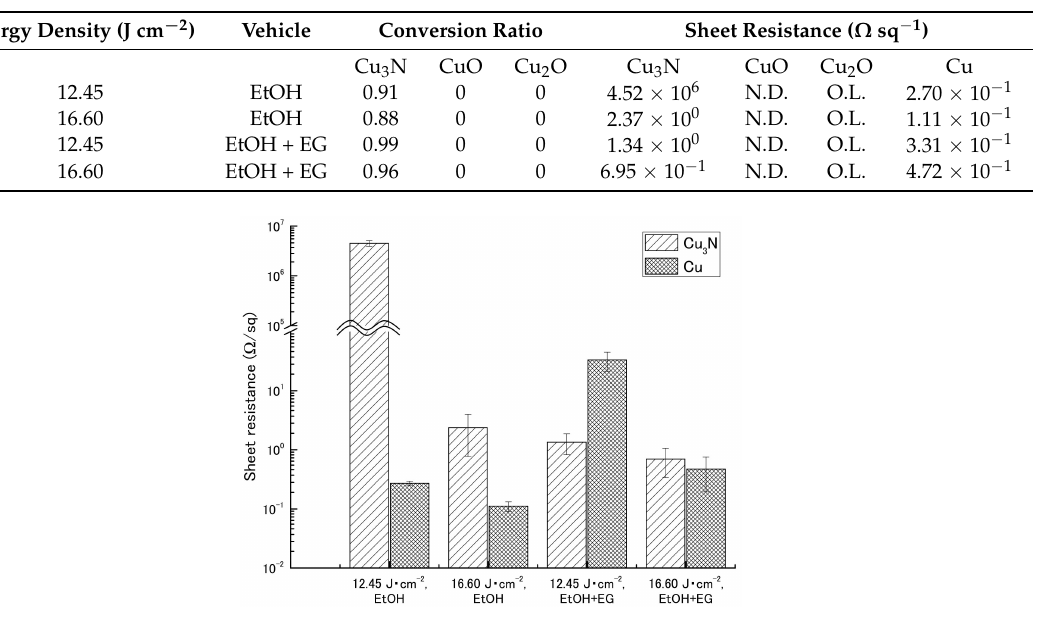
Figure 3. Sheet resistance of films containing copper nitride (Cu 3 N) and copper (Cu) after intense pulsed light sintering. Vehicle, ethanol (EtOH) with or without ethylene glycol (EG).